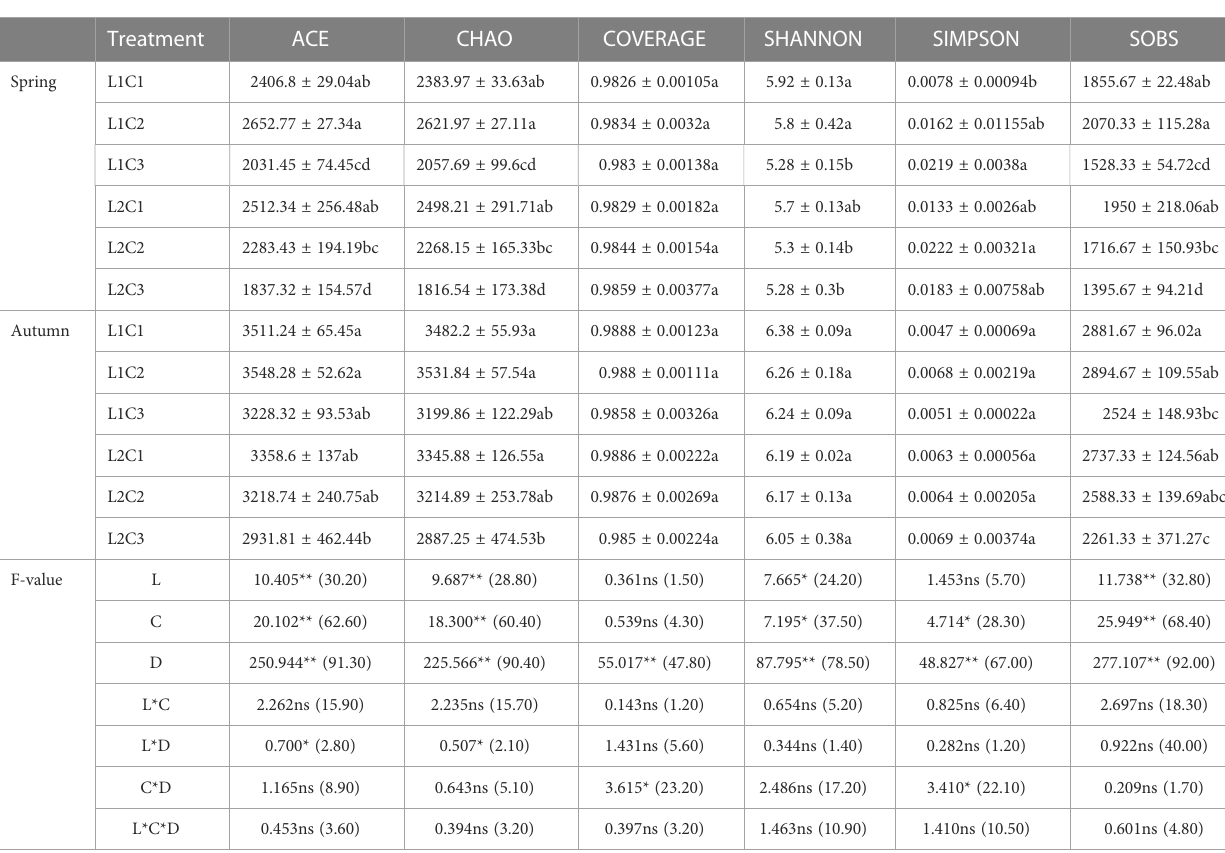
TABLE 3 Diversity of soil bacterial community